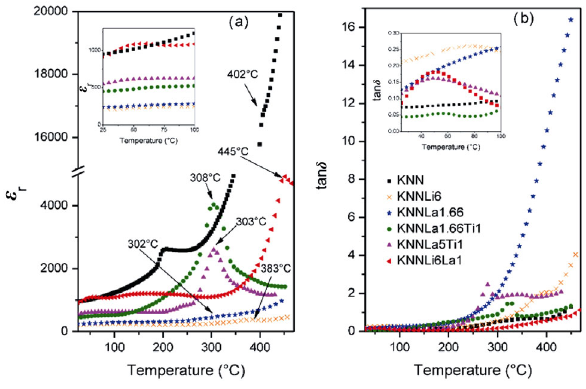
Fig. 10 (a) Relative dielectric permittivity ( ε r ) and (b) dielectric loss (tan δ ) of ceramic samples as a function of temperature at 1 kHz. Both cases show details of behaviors at low temperature.